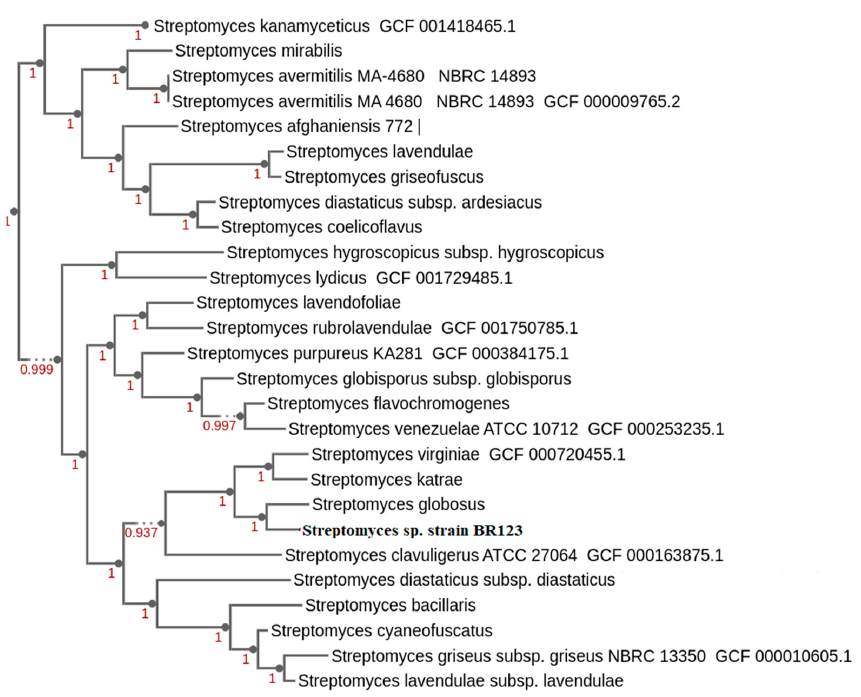
Figure 2. Whole genome-based tree of Streptomyces isolate BR123 with other Streptomyces strains, inferred using Kbase.